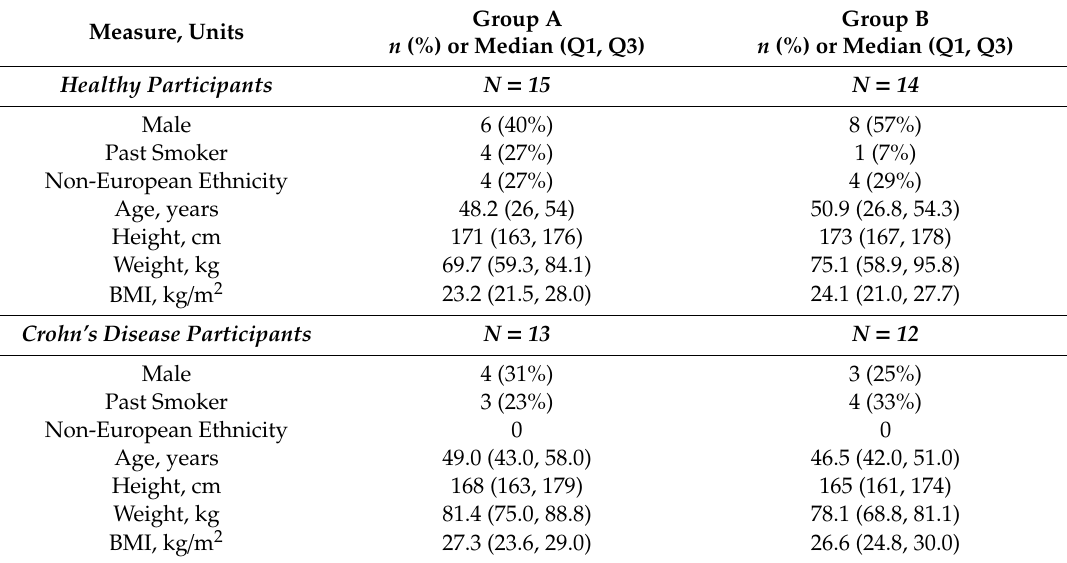
Table 2. Baseline characteristics of healthy and Crohn’s disease participants who began each